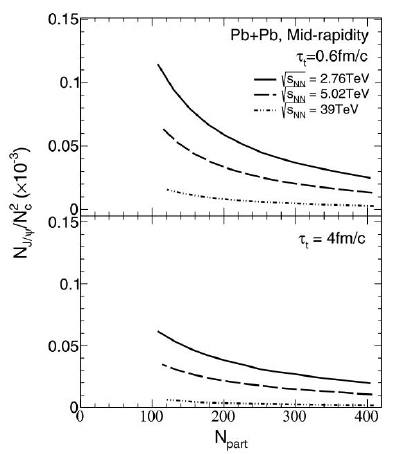
Figure 2. The ratio of J / ψ production to the square of the total charm pair number (with N c = + . . . including all charm flavor hadrons) as a function of the number of participants N D + N Λ c √ N part in Pb-Pb collisions. The collision energies are chosen as s NN = 2.76,5.02, 39 TeV, respectively. Charm quark momentum distribution is assumed to reach equilibrium at the beginning of medium expansion τ t = 0.6 fm/c in the upper panel and τ t = 4 fm/c in the lower panel. This figure is cited from Ref.